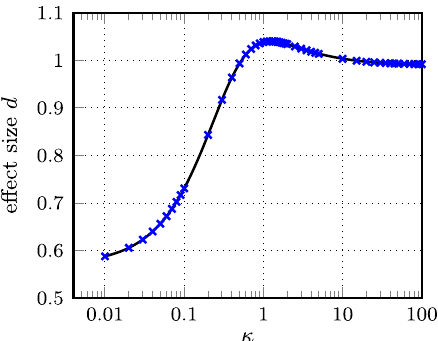
FIG. 5. Test combination analysis: Pre-post effect size (Cohen ’ s d ) of composite test score T ¼ T 1 þ κ T 2 as a function of κ . According to Eq. (11), data points were obtained from raw pre- and post-test scores by calculating the composite test score for each student using 50 different values of κ . The fit line was determined by Eq. (12) using θ 1 , θ 2 , and ϕ calculated from the data. Note that the κ axis is logarithmic in order to illustrate the relevant values of κ according to Table V with sufficient